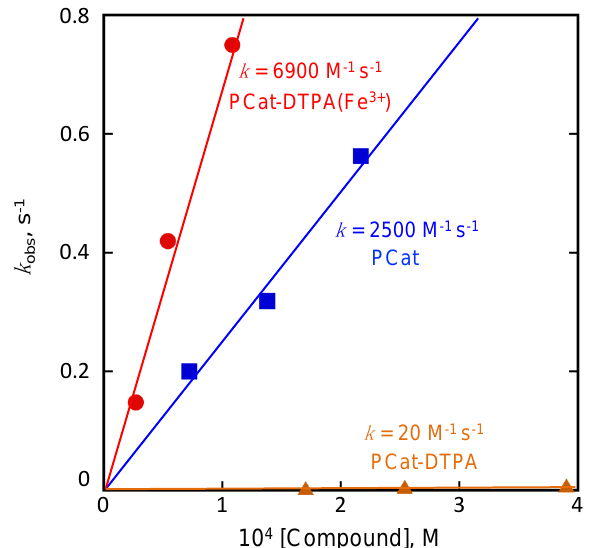
Figure 3. Plot of the pseudo-first-order rate constant ( k obs ) vs. the concentration of PCat (blue), PCat-DTPA (orange), and PCat-DTPA(Fe 3+ ) (red) for the radical scavenging reaction toward DPPH • .